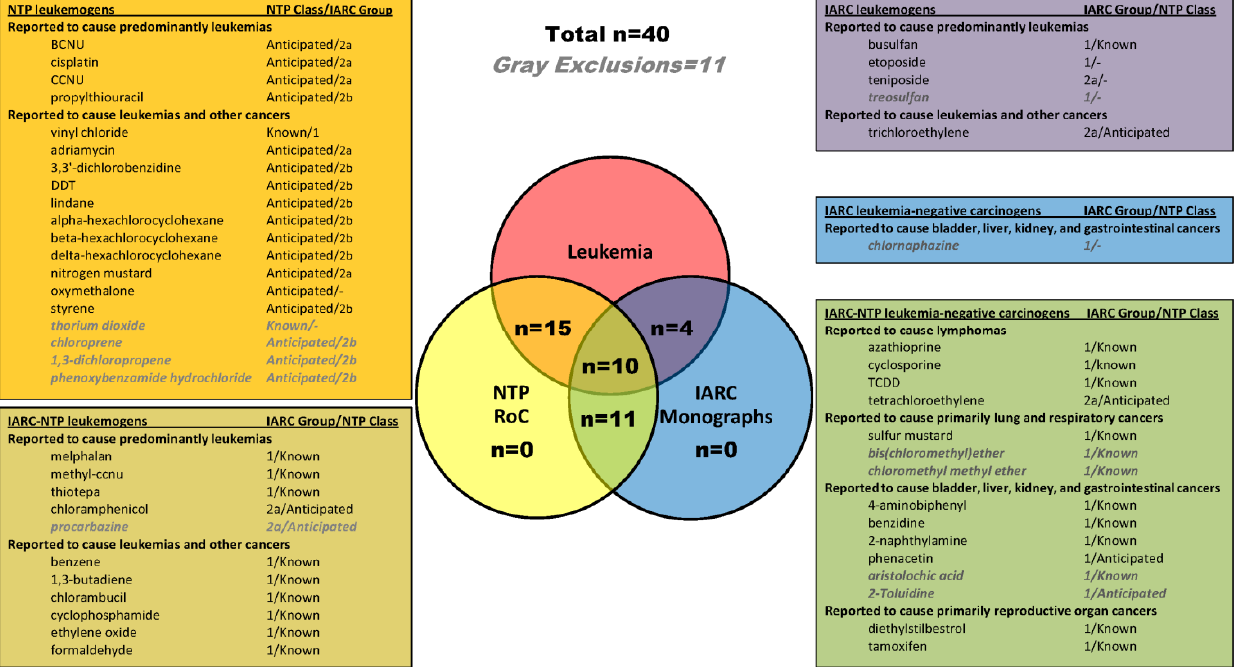
Figure 1. Human leukemogens and non-leukemogenic carcinogens identified from NTP and IARC reports. The Venn diagram shows the numbers of leukemogens (n = 29) and non-leukemogenic carcinogens (n = 11) identified from IARC and NTP, for which CTD data were available. The boxes detail the IARC and NTP carcinogen classifications of all 35 leukemogens and all 16 non-leukemogenic carcinogens, sorted by agency from which they were selected. Within the boxes, the chemicals are organized by reported disease associations, then by IARC group number, then alphabetically by name. “-” group or class indicates no report available. The 11 chemical names for which no CTD data were available are shown in